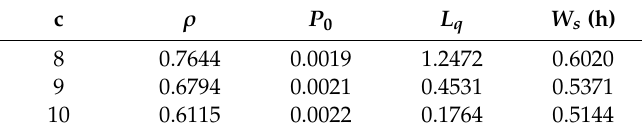
Table 6. M / M / c model parameters under di ff erent numbers.